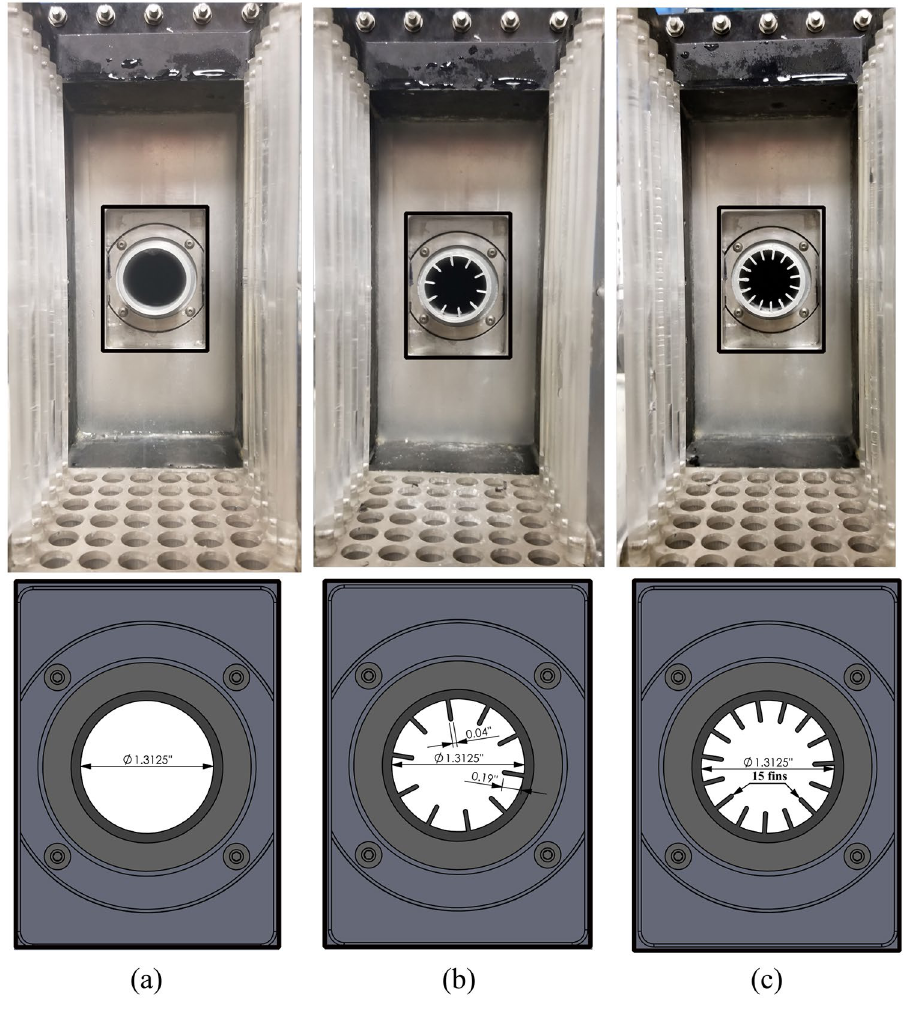
Figure 2. Three tested nozzle: ( a ) circular nozzle, ( b ) 10 fins shark-inspired nozzle, and ( c ) 15 fins shark- inspired nozzle.